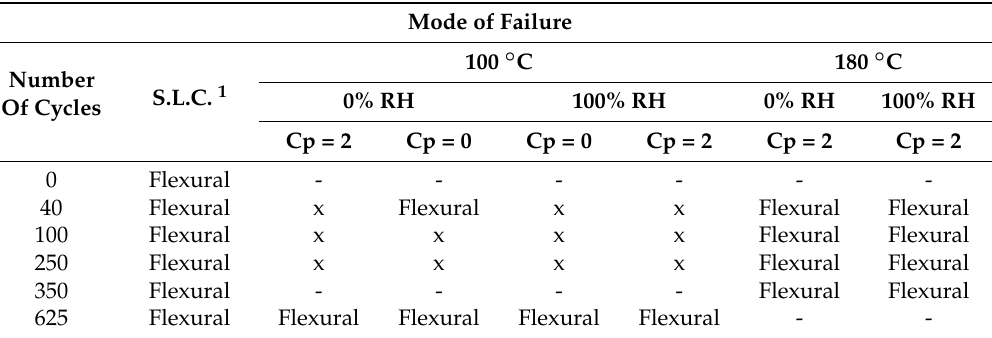
Table 3. Mode of failure under different environmental